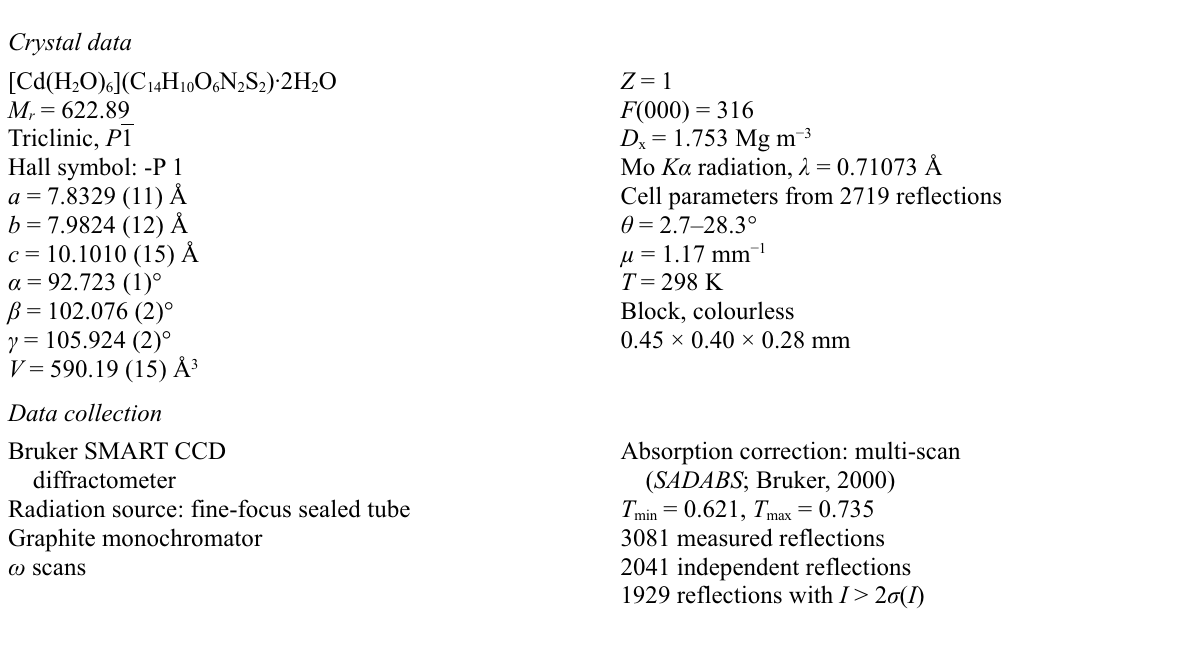
Figure 1 The molecular structure of (I) showing 50% displacement ellipsoids for the non-hydrogen atoms. Symmetry codes: (i) 1– x, 1–y, 1–z; (ii) 1–x, 1–y, –z. Hexaaquacadmium(II) 2,2 ′ -(azinodimethylidyne)dibenzenesulfonate